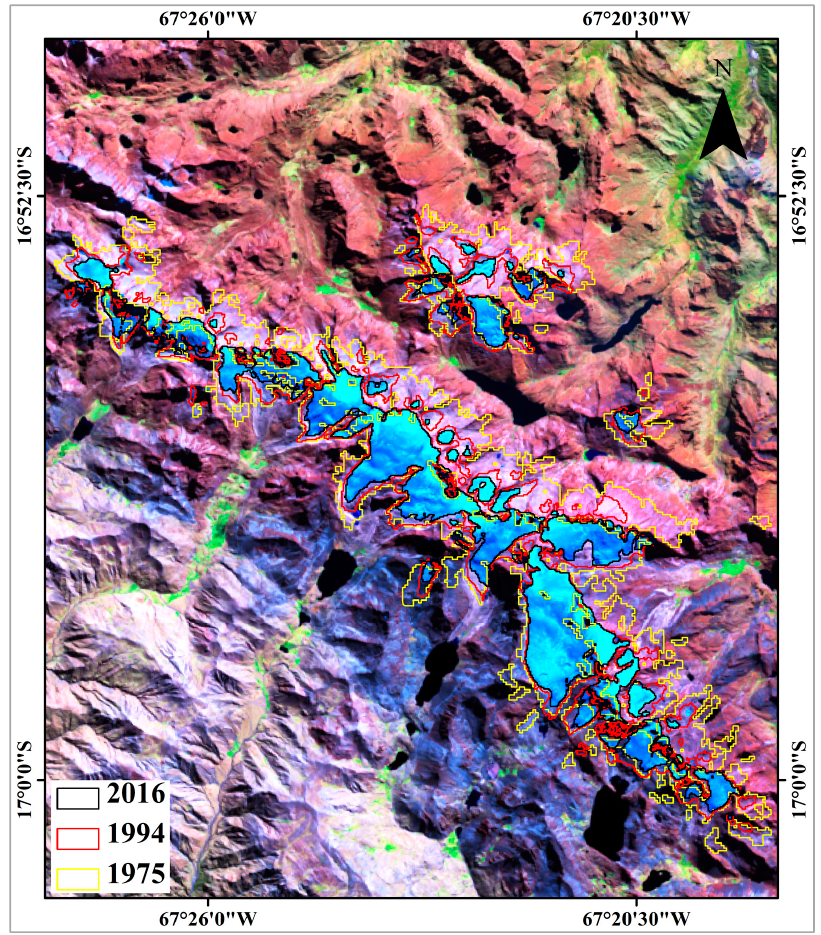
Figure 2. Glacier recession in the Cordillera Tres Cruces in the Bolivian Andes between 1975 and